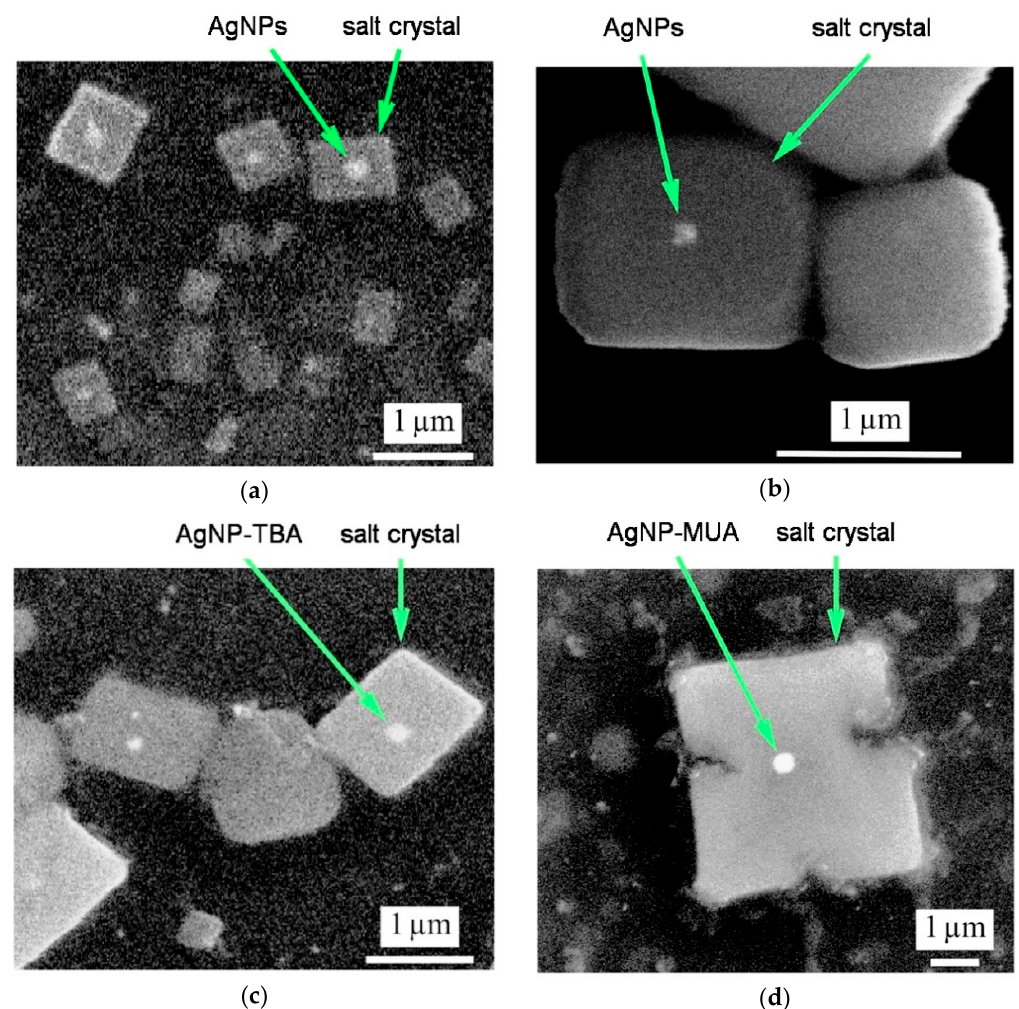
Figure 1. Scanning electron microscopy (SEM) micrographs of synthesized silver nanoparticles (AgNPs): ( a ) SEM micrograph of naked AgNPs. Arrows indicate AgNPs and salt crystals; ( b ) Magnified zone of naked AgNPs showing the salt crystal; ( c ) Micrograph showing of AgNP-thiobarbituric acid (TBA) nanoparticles and concomitant salt crystals; ( d ) Magnified view of AgNP-11-mercaptoundecanoic acid (MUA) nanoparticles within a salt crystal.